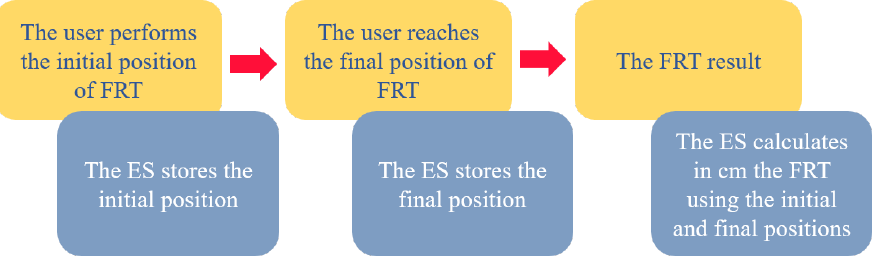
Figure 2. Functioning sequence of the experimental system